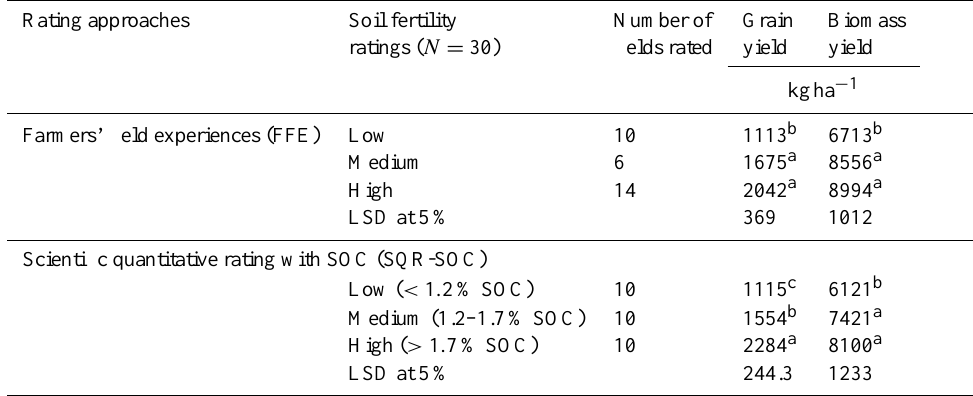
Table 2. Maize grain and biomass yield in fields rated using the FFE and SQR-SOC techniques in a Ferralsol in Uganda. Rating